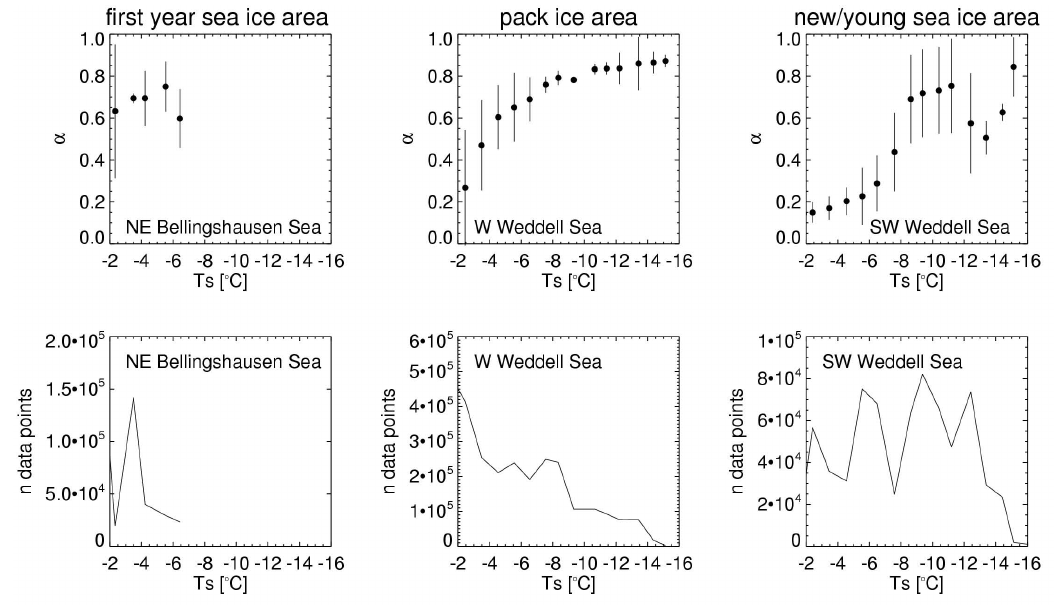
Fig. 4. From left to right, upper row: bin-averaged surface temperature values 1T =1 ◦ C below freezing point versus albedo of the sea surface measured in the north-eastern Bellingshausen Sea covered mainly with first year ice; the western Weddell Sea pack ice area and the southern part of the western Weddell Sea ice area, covered mainly with new and young ice. Lower row shows number of data points versus surface